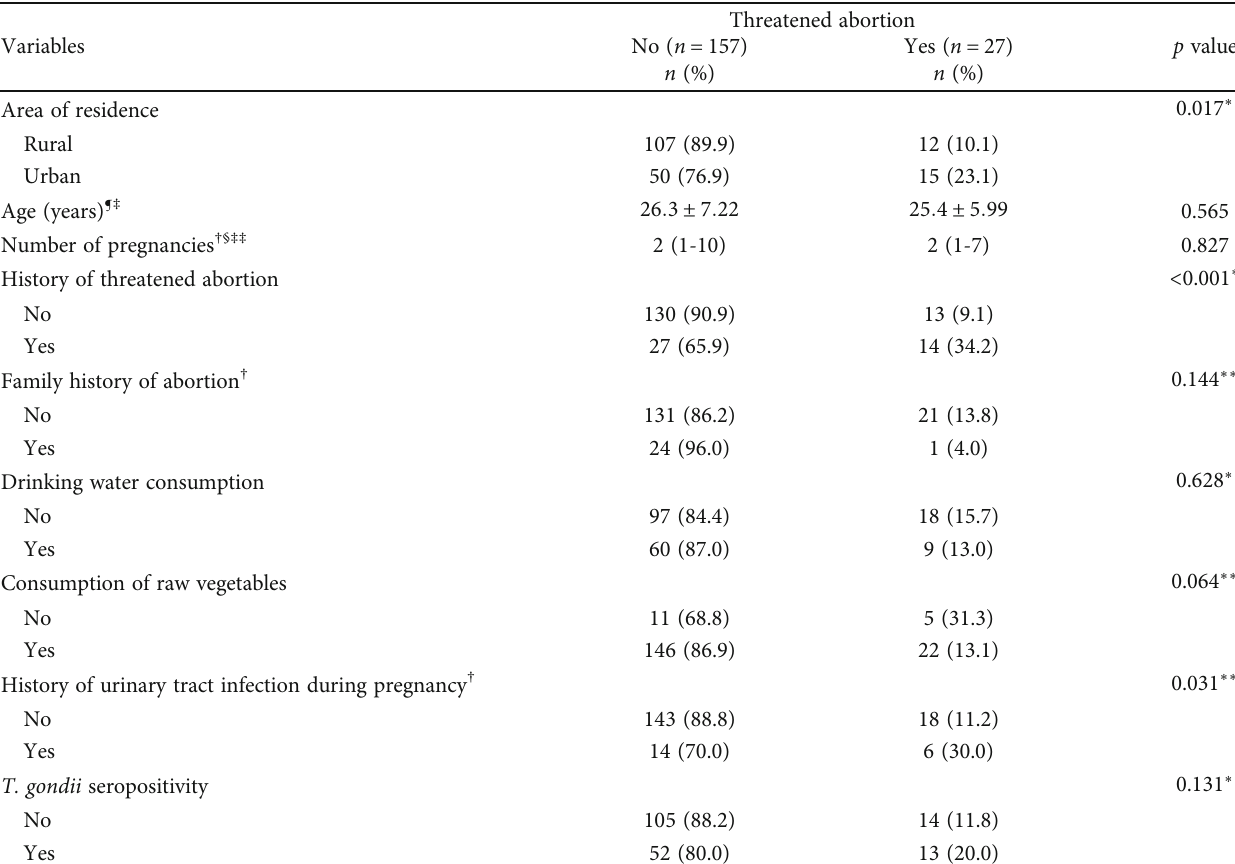
Table 2: T. gondii seropositivity and other factors associated with threatened abortion in pregnant women, bivariate analysis.